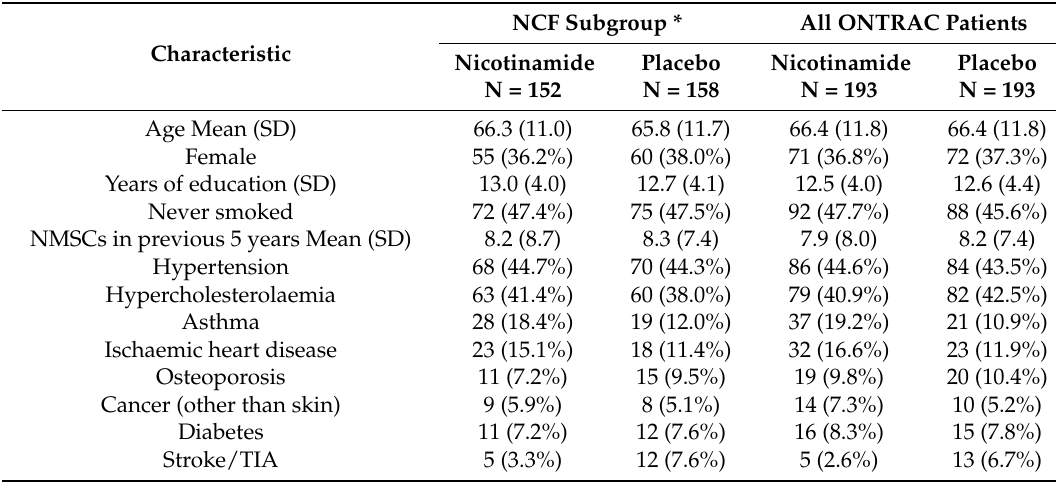
Table 1. Baseline